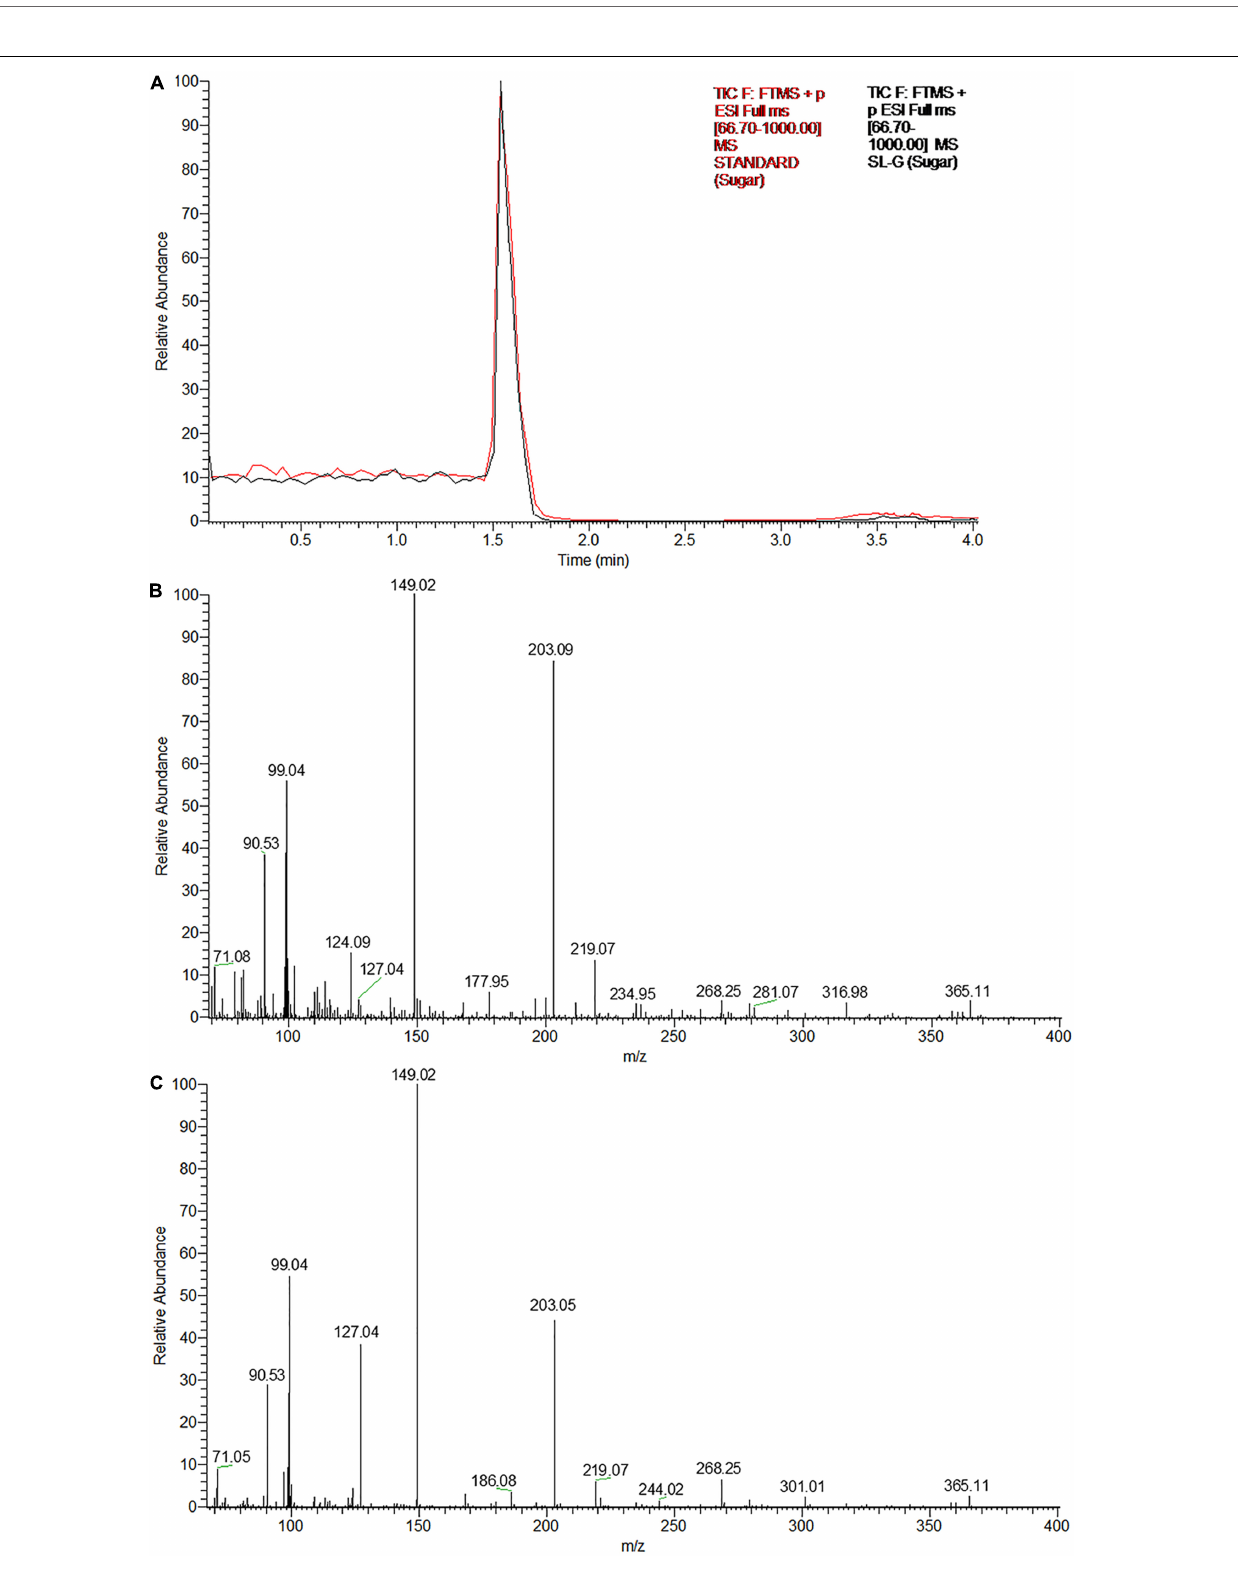
Frontiers in Microbiology |